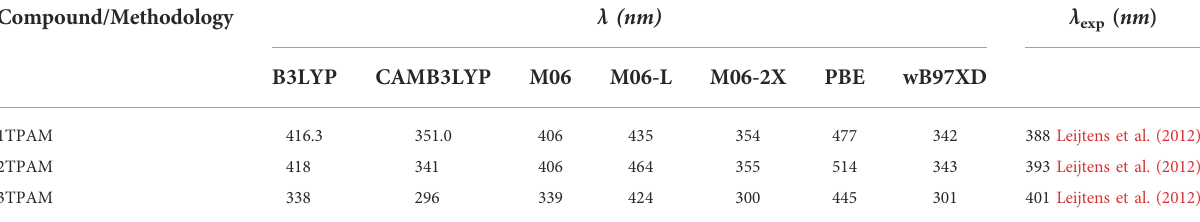
TABLE 2 Maximum absorption wavelength for 1, 2, and 3TPAM calculated with different funcionals and 6-311++G(d,p) basis set; and the comparison with the experimental value. Compound/Methodology